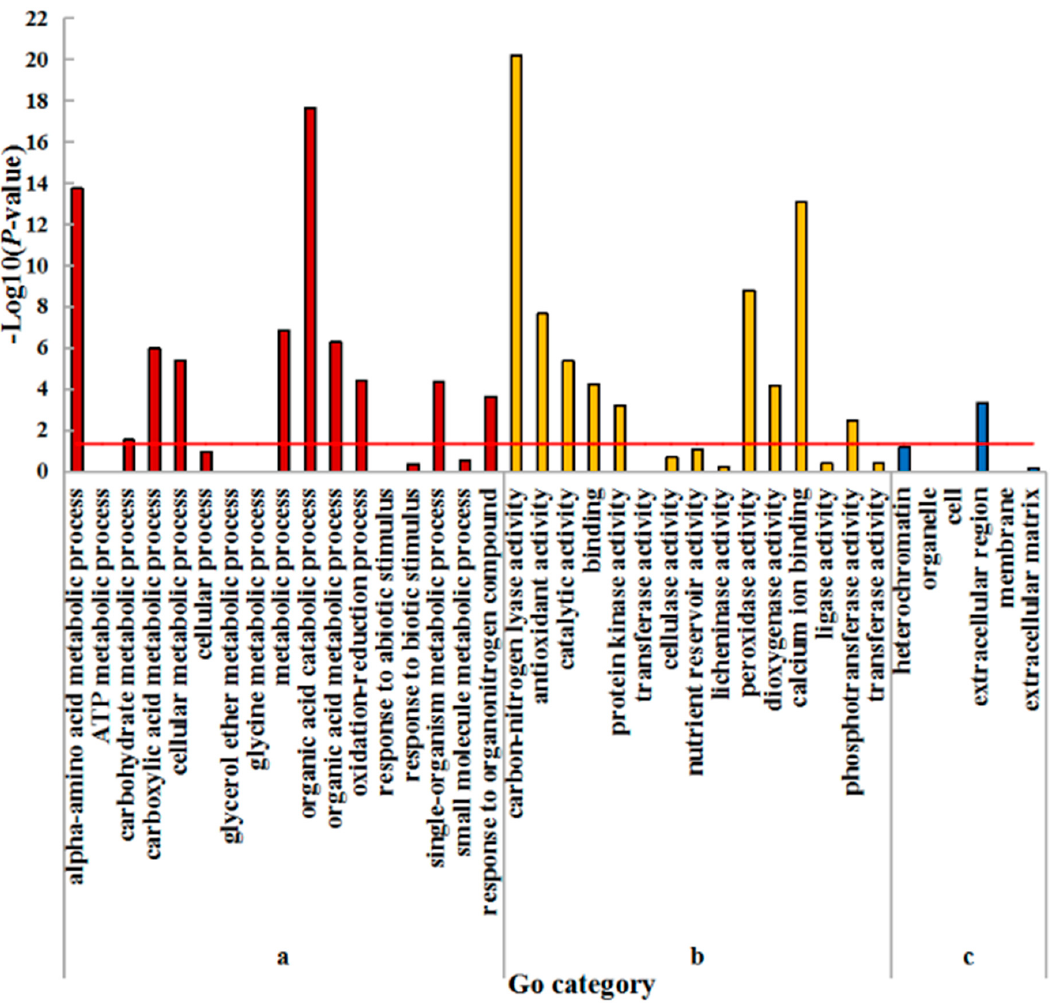
Figure 3. GO enrichment analysis of DEGs in roots of wheat seedlings. ( a ) Biological process; ( b ) Molecular function; ( c ) Cellular component. The hypergeometric distribution calculates the p -value which determines the significance of enrichment, and the red line represents the p -value of 0.05.